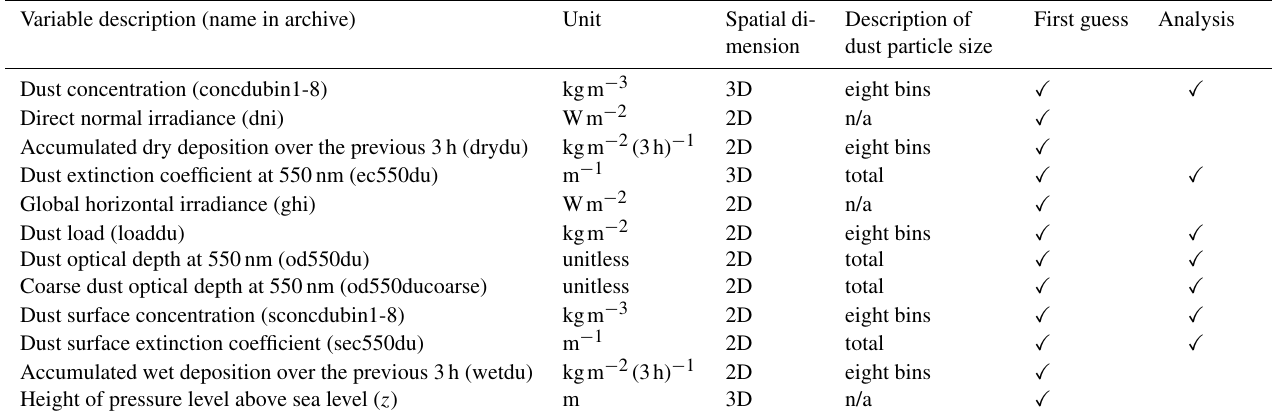
Table 2. List of reanalysis variables. For each variable the following ensemble statistics are calculated and archived: ensemble mean, standard deviation, max and median. n/a – not applicable.